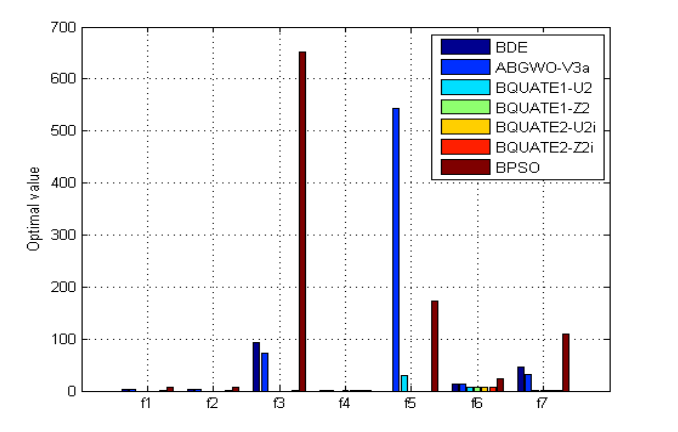
Figure 9. The optimal values of BDE, ABGWO-V3a, BQUATE1-U2, BQUATE1-Z2, BQUATE2-U2i, BQUATE2-Z2i, and BPSO on f1-f7.